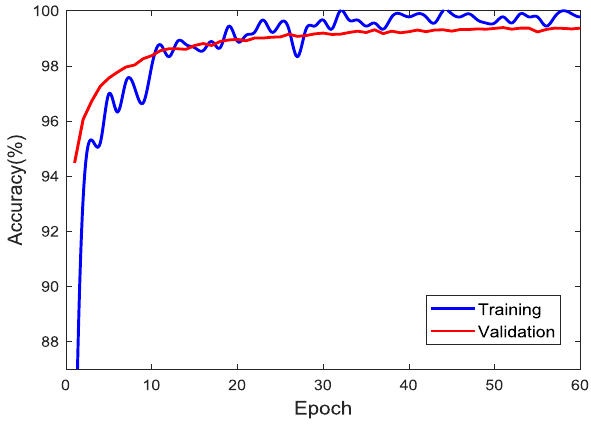
Figure 7. Accuracy of training and validation.